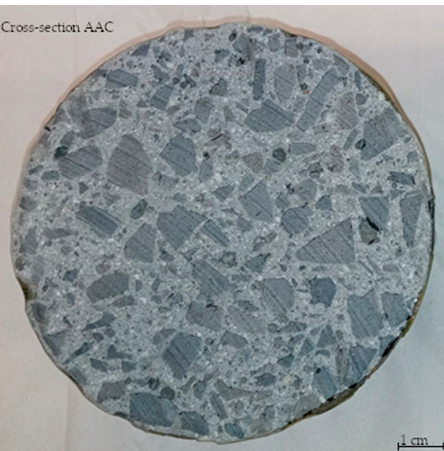
Figure 3. Cross-section of the concrete cylinder sample of 11 cm diameter and 5 cm height.